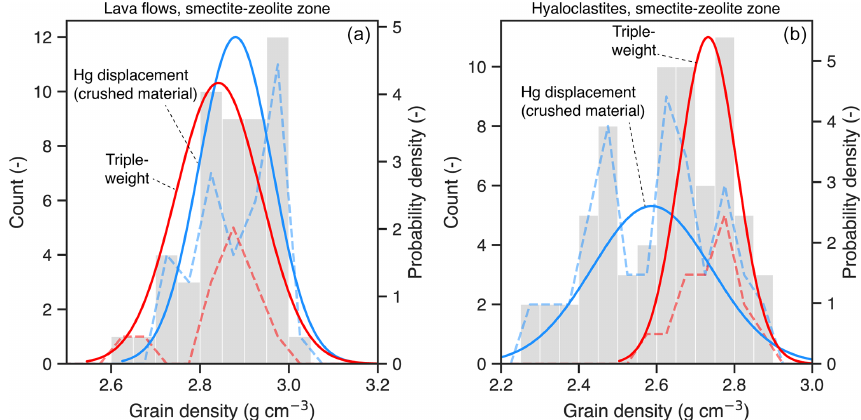
Figure 4. Grain density obtained by mercury displacement (dashed blue lines) and triple weighting (dashed red lines) for (a) lava flows and (b) hyaloclastites. All data are shown in gray, and a normal distribution fit to the data for each respective measurement technique is shown using solid blue or solid red lines. Note that all of the samples for which grain density was measured by triple weighting were core samples, whereas most of the samples for which grain density was measured using Hg displacement were surface samples. This could affect the difference seen in panel (b)